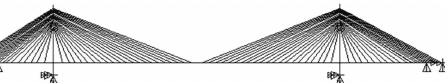
(ii) the mass density and Young’s modulus of the towers ( 𝜌 𝑡 , 𝐸 𝑡 ) and cables ( 𝜌 𝑐 , 𝐸 𝑐 ); (iii) the constant of transverse springs in the